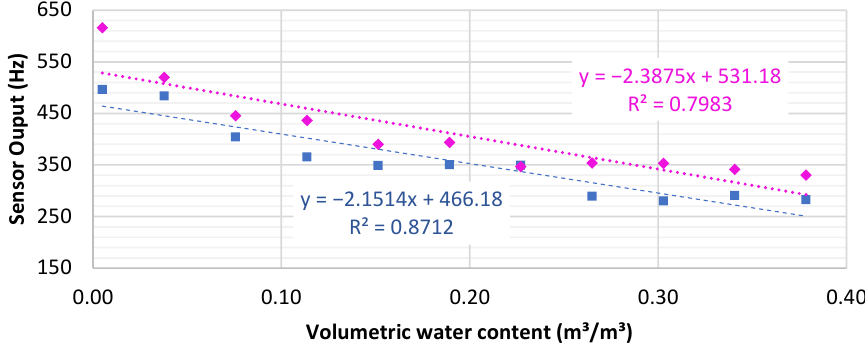
Figure 6. Sensor response and linear calibration curves under 3.3 V (pink dots and curve) and 5.5 V (blue dots and curve) input voltage.